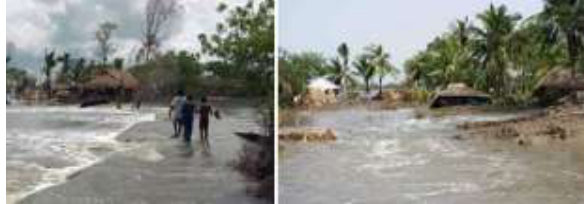
Figure 6. Devastating photographs of Cyclone